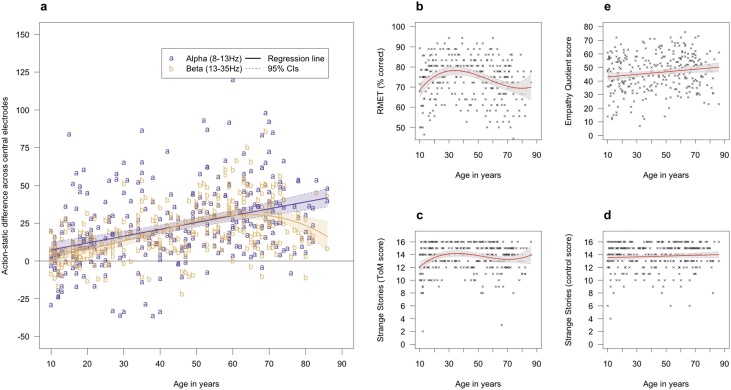
Relationship between age (in years) and a) the mean percentage change in alpha and beta power in the central electrodes from static hand observation to hand action observation in the action observation EEG task, b) percentage correct in Reading the Mind in the Eyes Task (RMET), c) Empathy Quotient (EQ) total score, d) Strange Stories Theory of Mind (ToM) score, and e) Strange Stories control score. The bold line indicates the best-fitting regression line and the dashed line indicates the 95% confidence intervals (CIs).